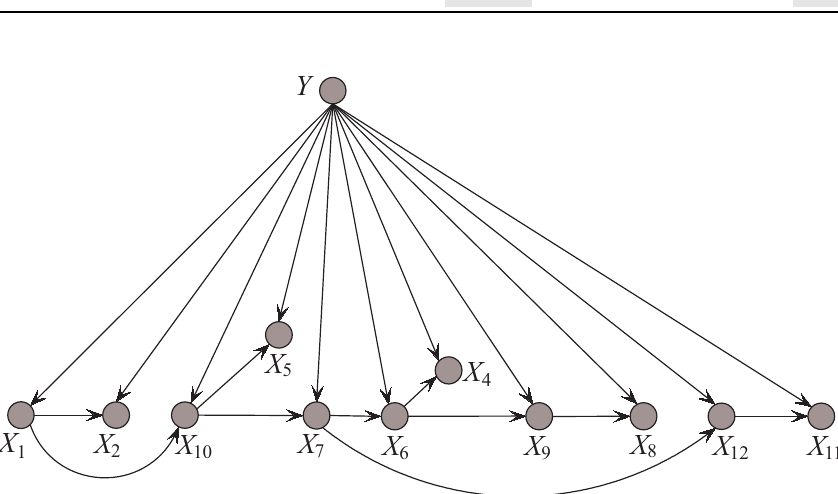
Figure 5. The topology of TAN corresponding to the CMI matrix shown in Table